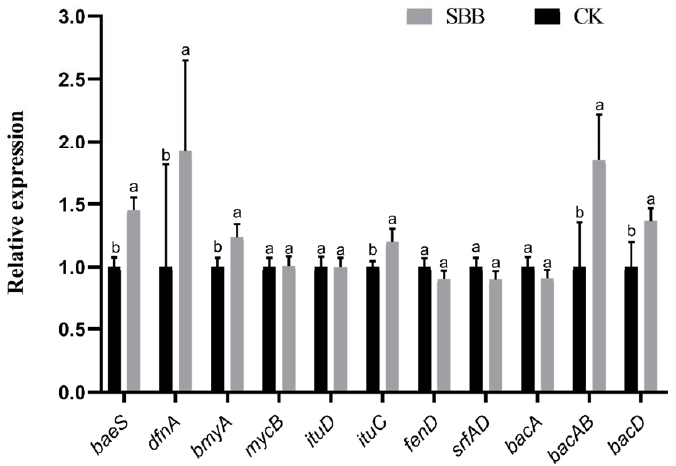
Figure 9. Relative expression levels of Bacillus velezensis SBB antibiotic-related genes. Data are the means ± SE. Different letters indicate statistically significant differences ( p < 0.05) among treatments ( t ‐ test).